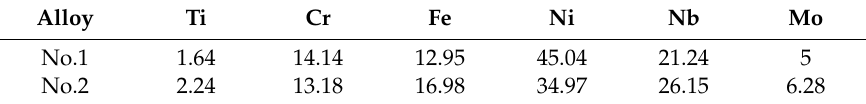
Table 3. Chemical composition of Laves phase (wt.%).